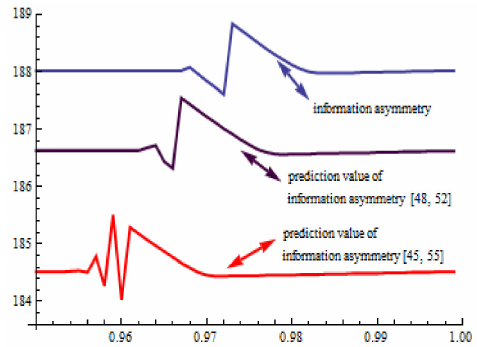
Figure 2. Trend chart of the optimal wholesale price.